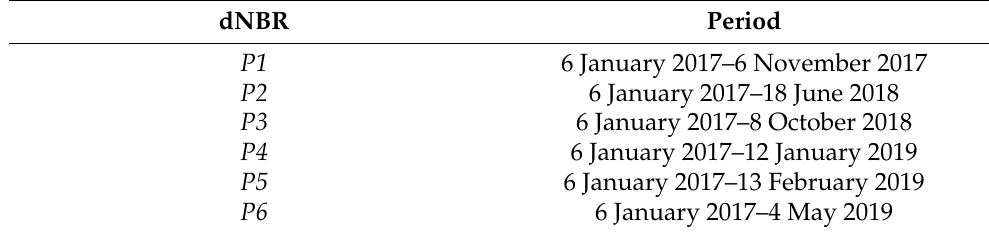
Table 2. dNBR products in different periods ( P